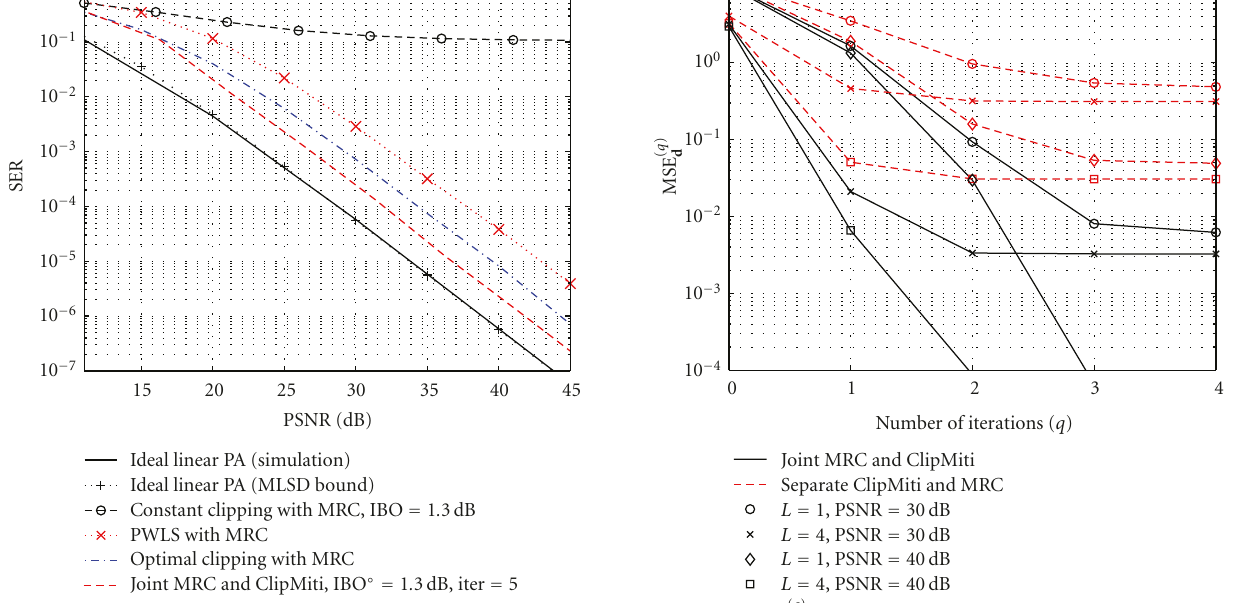
Figure 2: The SER versus PSNR curves for the constant clipping (IBO = 1 . 3dB), PWLS, optimal clipping, joint MRC and clipping mitigation (with the optimal IBO ◦ = 1 . 3dB and five iterations) schemes, as well as the assumed ideal case with IBO = 0dB but no clipping. N r = 2.